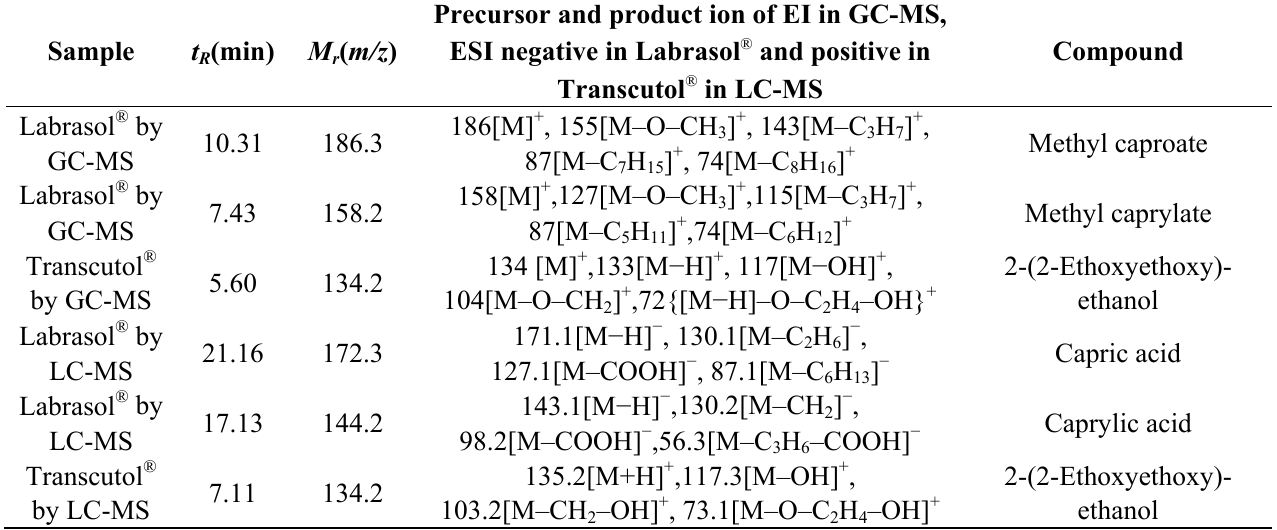
Table 2. Analytical parameters for the identification of Labrasol ® and Transcutol ® by GC-MS with EI ion source, and LC-MS with ESI ion source. t denotes relative molecular mass. M r